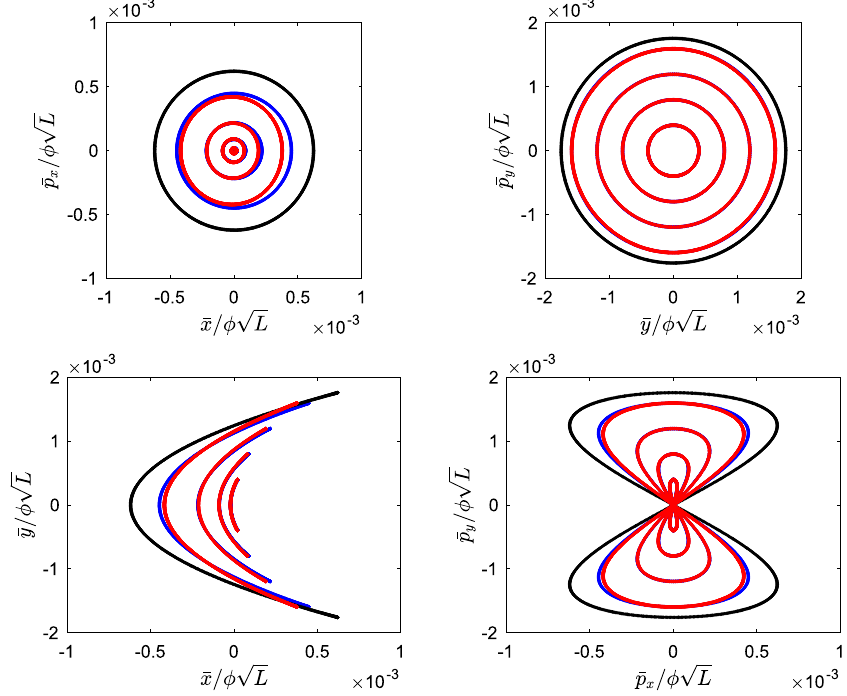
2 ν 0 . 618 and ν 0 . 196 . The with ν x þ y x ¼ y ¼